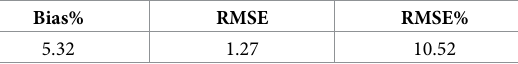
Table 3. The results of the trees detection.